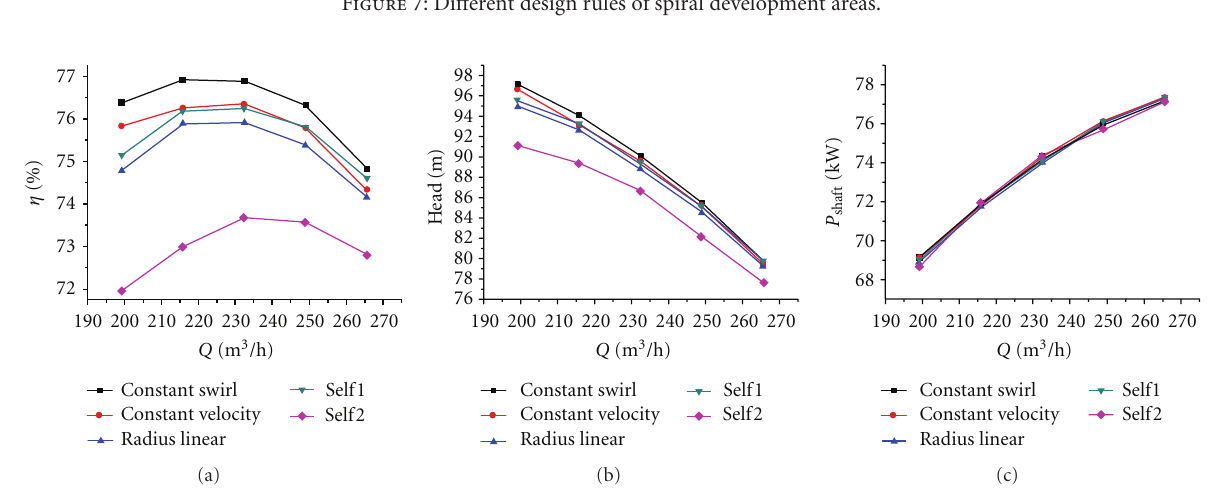
Figure 8: (a) Q - η curve, (b) Q - H curve, and (c) Q - P shaft